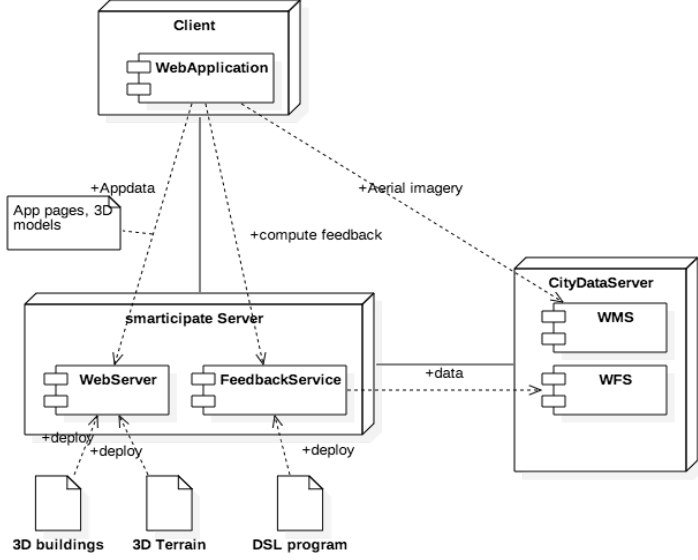
Figure 9. Detailed Feedback service design and dependent environment.